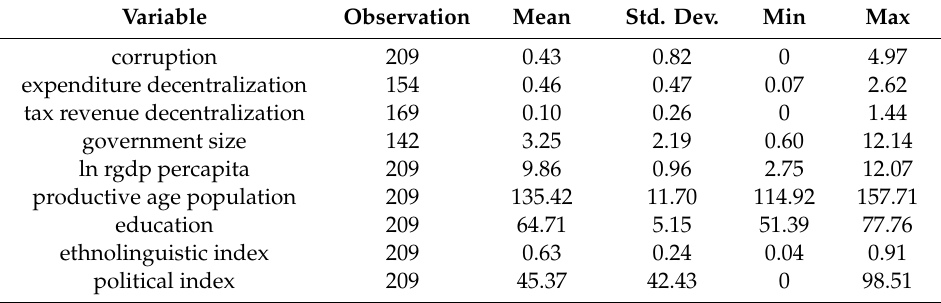
Table 1. Descriptive Statistics.